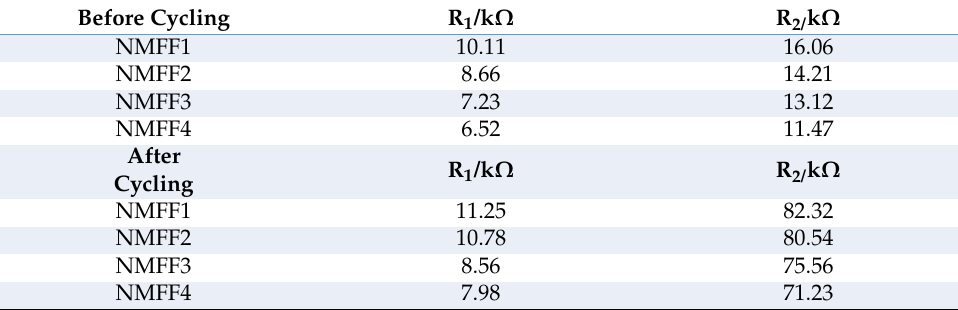
Figure 10. The FESEM images of the samples, taken after 500 cycles. To determine the electrode’s kinetic performance, EIS analysis was performed for the electrode at different conditions as shown in Table 2. The fluorine-added NaFe 1-x Mg x O 2 (NMFF4) shows the large semicircle at the high-frequency region followed by a quasi semi-circle at medium frequency followed by a straight line, which shows the conductive nature of the sample even at a low frequency. Table 2. Resistance value calculated from EIS analysis.